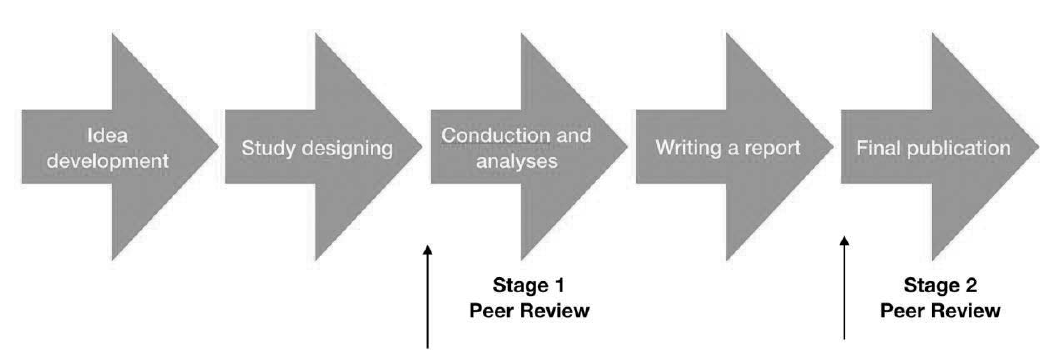
Figure 1. Registered Reports publishing